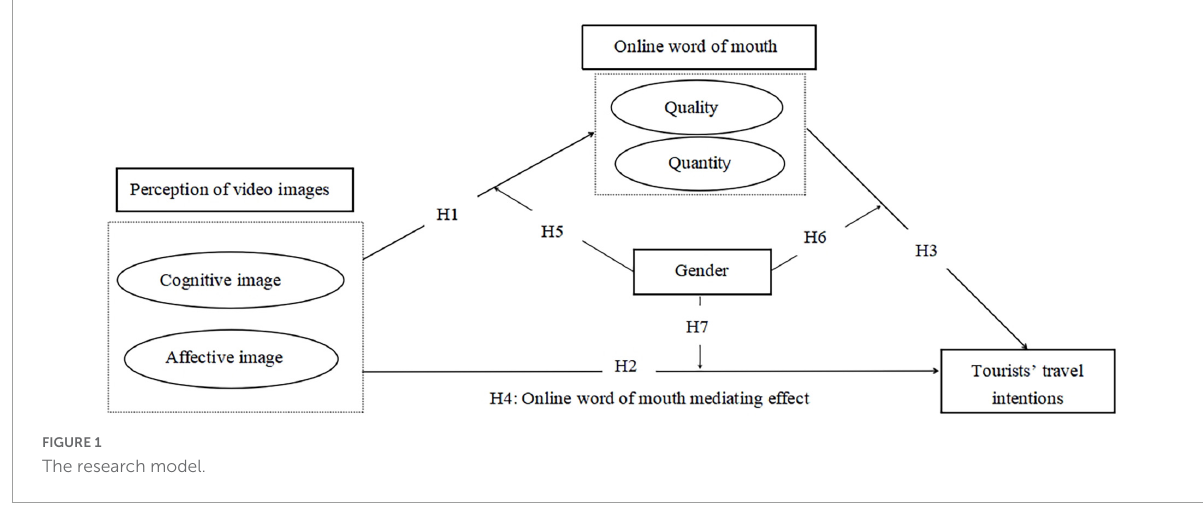
TABLE 1 The composition and distribution of the sample ( N =